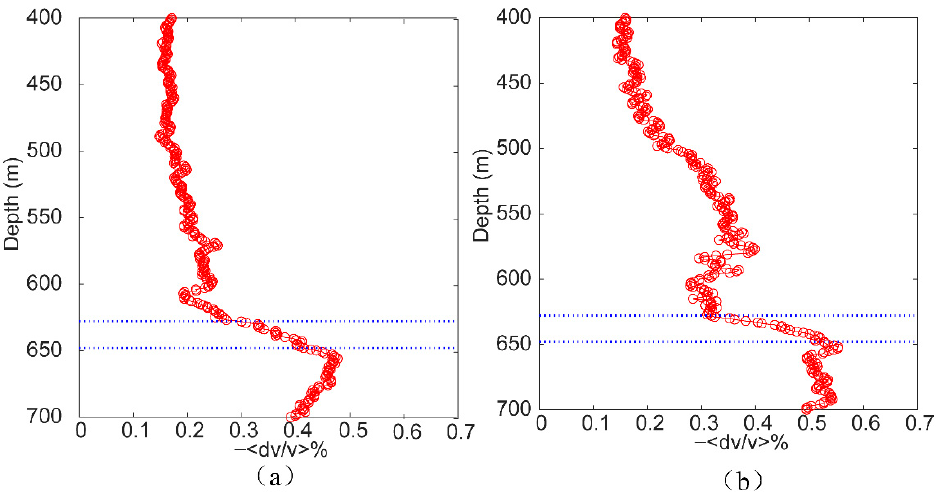
Figure 9. The estimated mean velocity change versus the receiver depth from the baseline survey and first-repeat survey using ( a ) CWI processing of the downgoing waves of the vertical component and ( b ) CWI processing of the downgoing waves of the horizontal component. The CO 2 injection layer is indicated by blue dotted lines.